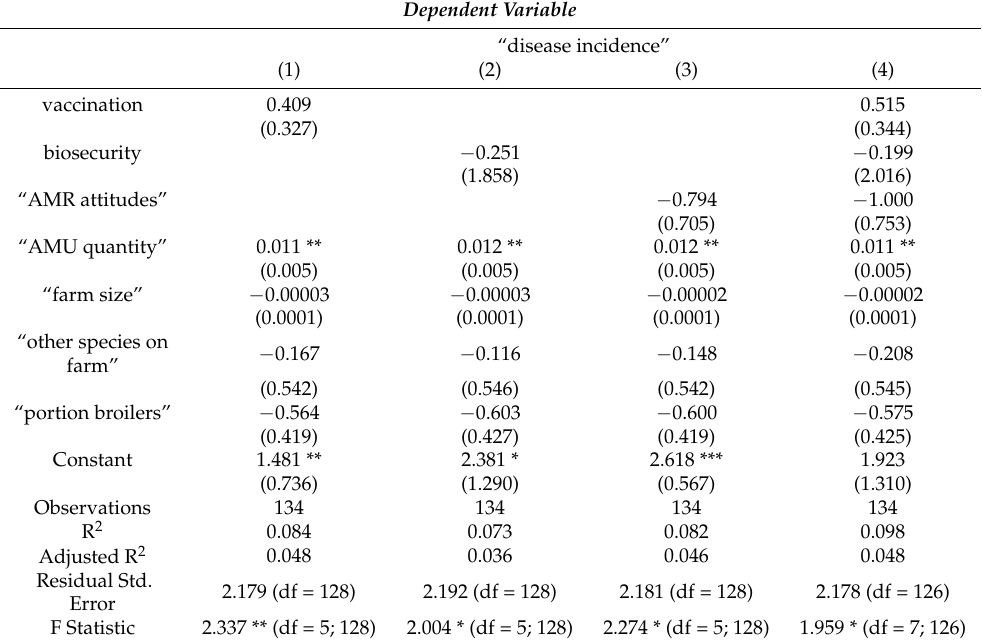
Table 4. Determinants of disease